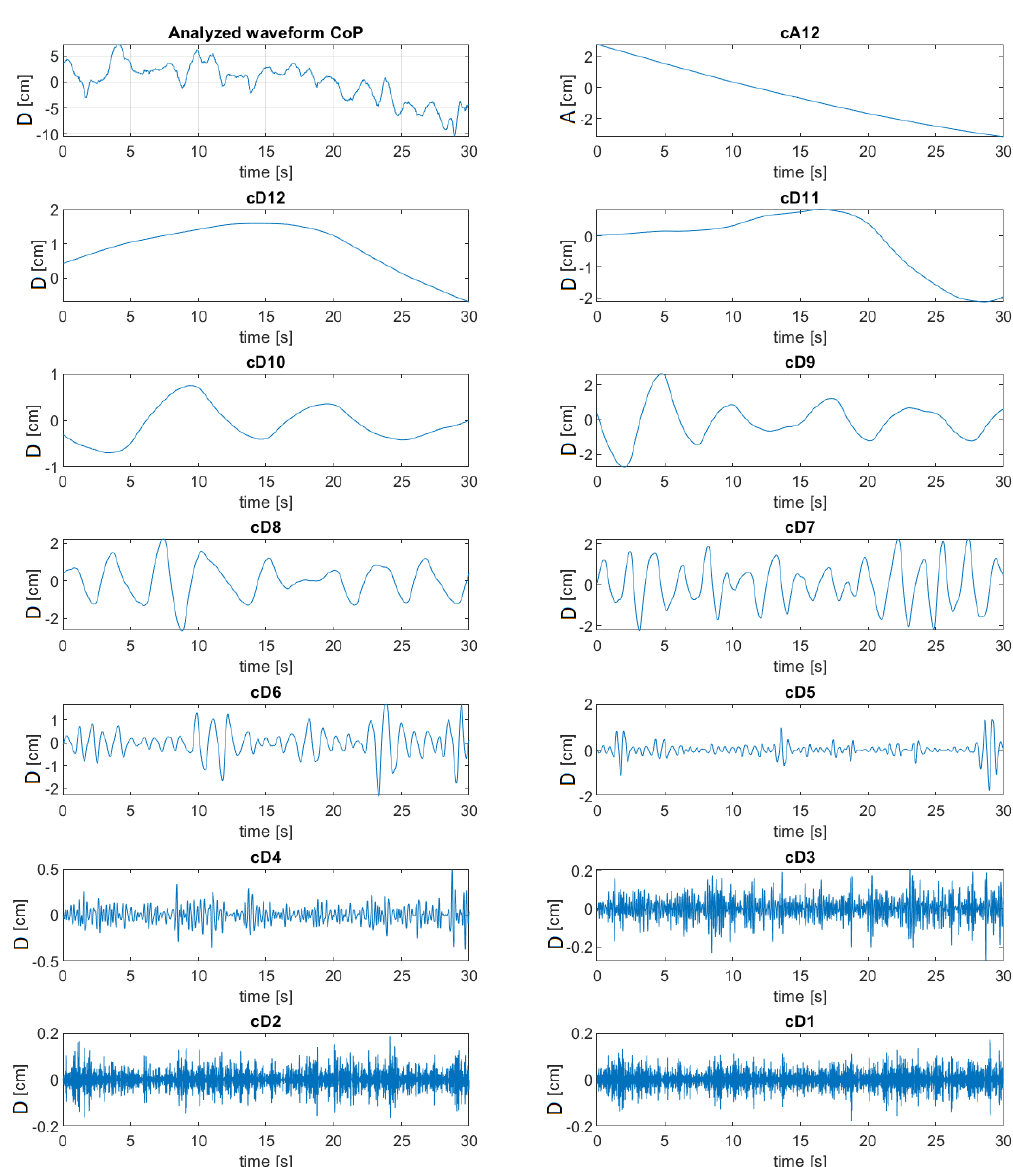
Figure 3. Signals in the field of time at levels subsequent to decomposition of Center of Pressure (CoP) displacement signals for a randomly selected person.